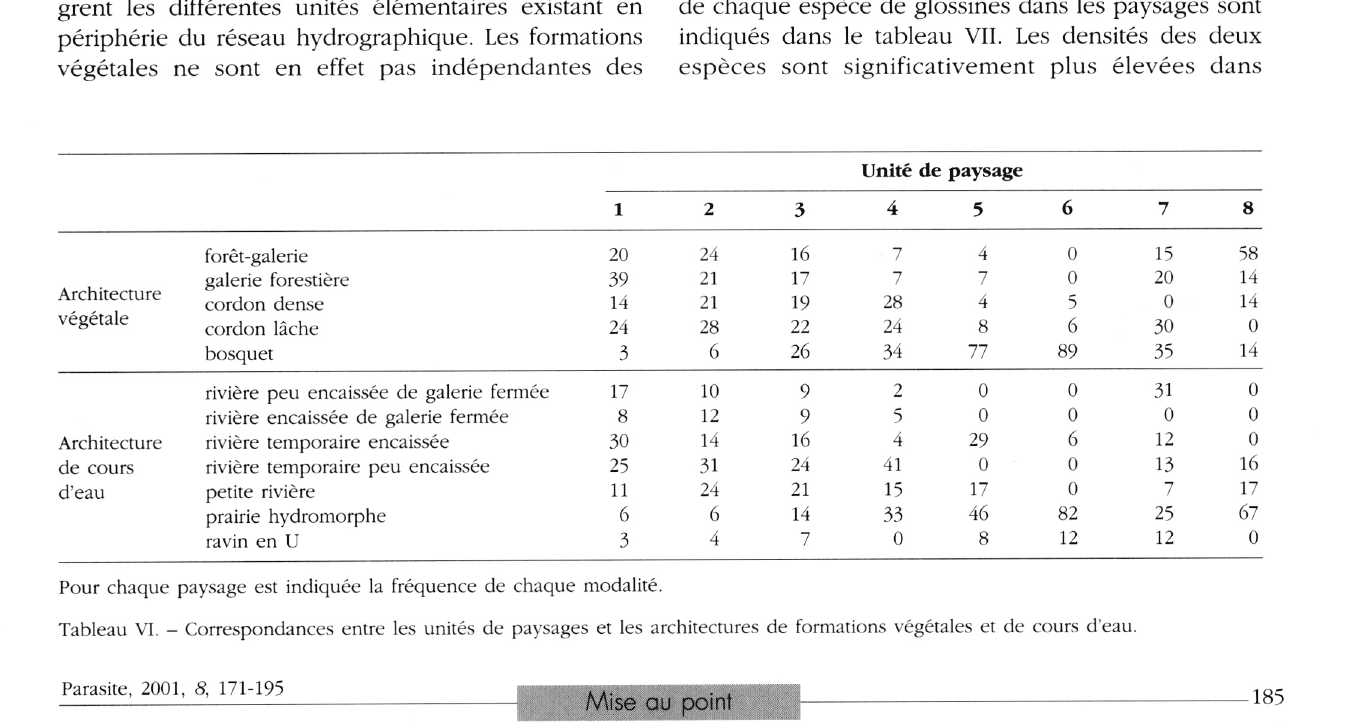
Tableau VI. - Correspondances entre les unités de paysages et les architectures de formations végétales et de cours